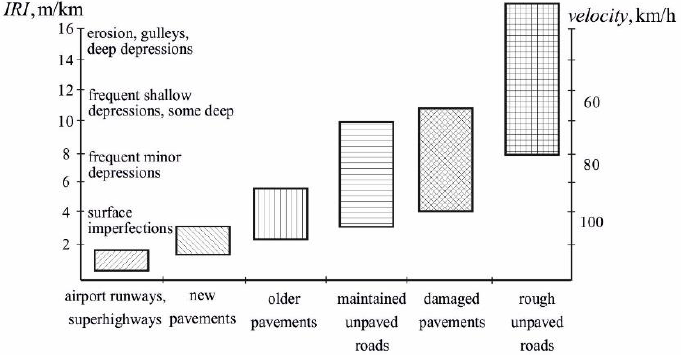
Figure 1. The IRI roughness scale [13].